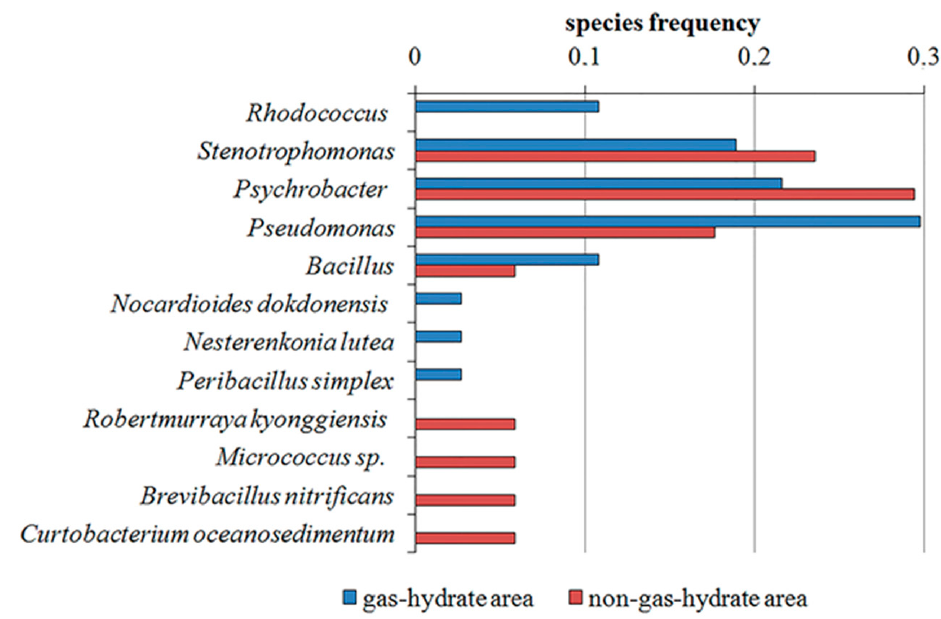
Figure 3. The frequency of occurrence of genera and species in the gas-hydrate and non-gas- hydrate